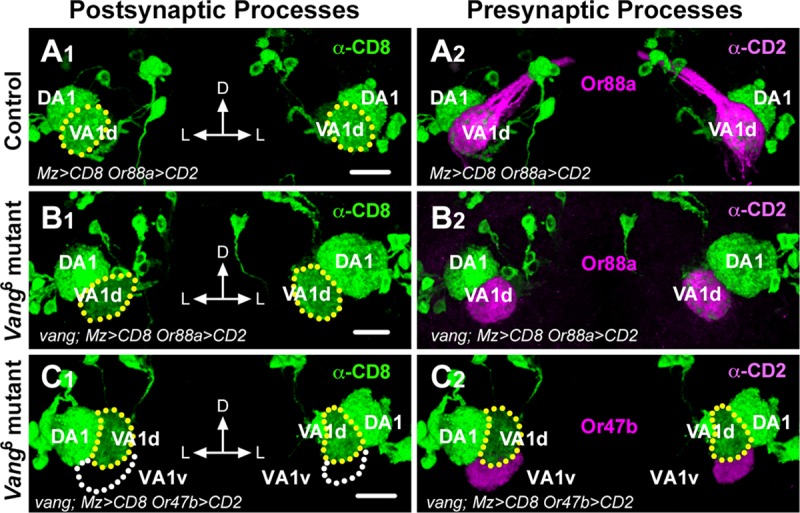
Vang does not function in ORN axon projection or pairing with cognate PN dendritic partners.(A, B) Adult brains from animals expressing Or88a-CD2 and UAS-mCD8::GFP under the control of Mz19-Gal4 were stained with anti-CD2 (magenta) and anti-CD8 (green) to visualize the pre- and postsynaptic processes of the VA1d and VA1v glomeruli. In the wild-type control, Or88a axons are faithfully paired with the VA1d dendrites (A). Collaterals form a fascicle, which innervates the contralateral AL. In the Vang6 mutant, Or88a axons are also faithfully paired with the VA1d dendrites (B). Vang mutant axons fail to sprout collaterals as previously reported [29]. (C) Frontal views of adult ALs from Vang6 mutants expressing Or47b-CD2 and UAS-mCD8::GFP under the control of Mz19-Gal4 stained with anti-CD2 (magenta) and anti-CD8 (green). In the mutant, Or47b axons targeted the adjacent VA1v glomerulus without straying into the VA1d glomerular territory. Scale bar: 10 μm.